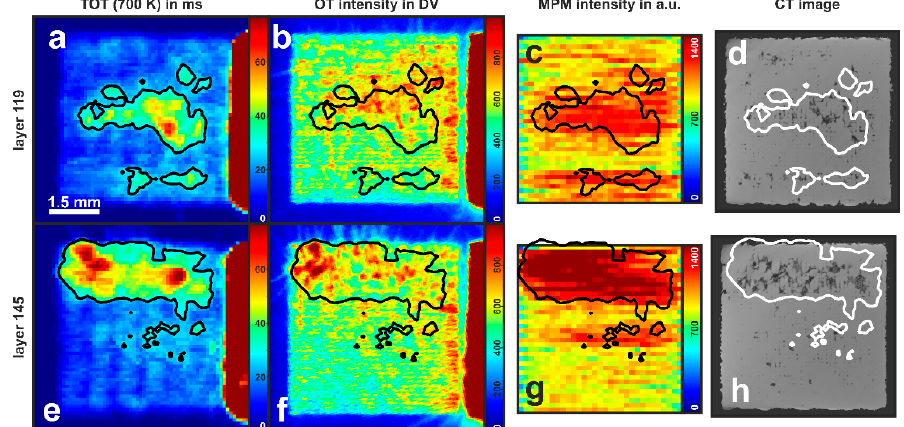
Figure 9. Comparison of data from in-situ monitoring with micro computed tomography ( µ CT) data for selected layers (( a – d ): layer 119; ( e – h ): layer 145), showing the low VED volume B. Contour lines of the TOT (700 K) signal at a threshold value of 30 ms are overlayed in all datasets to guide the eye. Artificial Defects with Standard Process Parameters